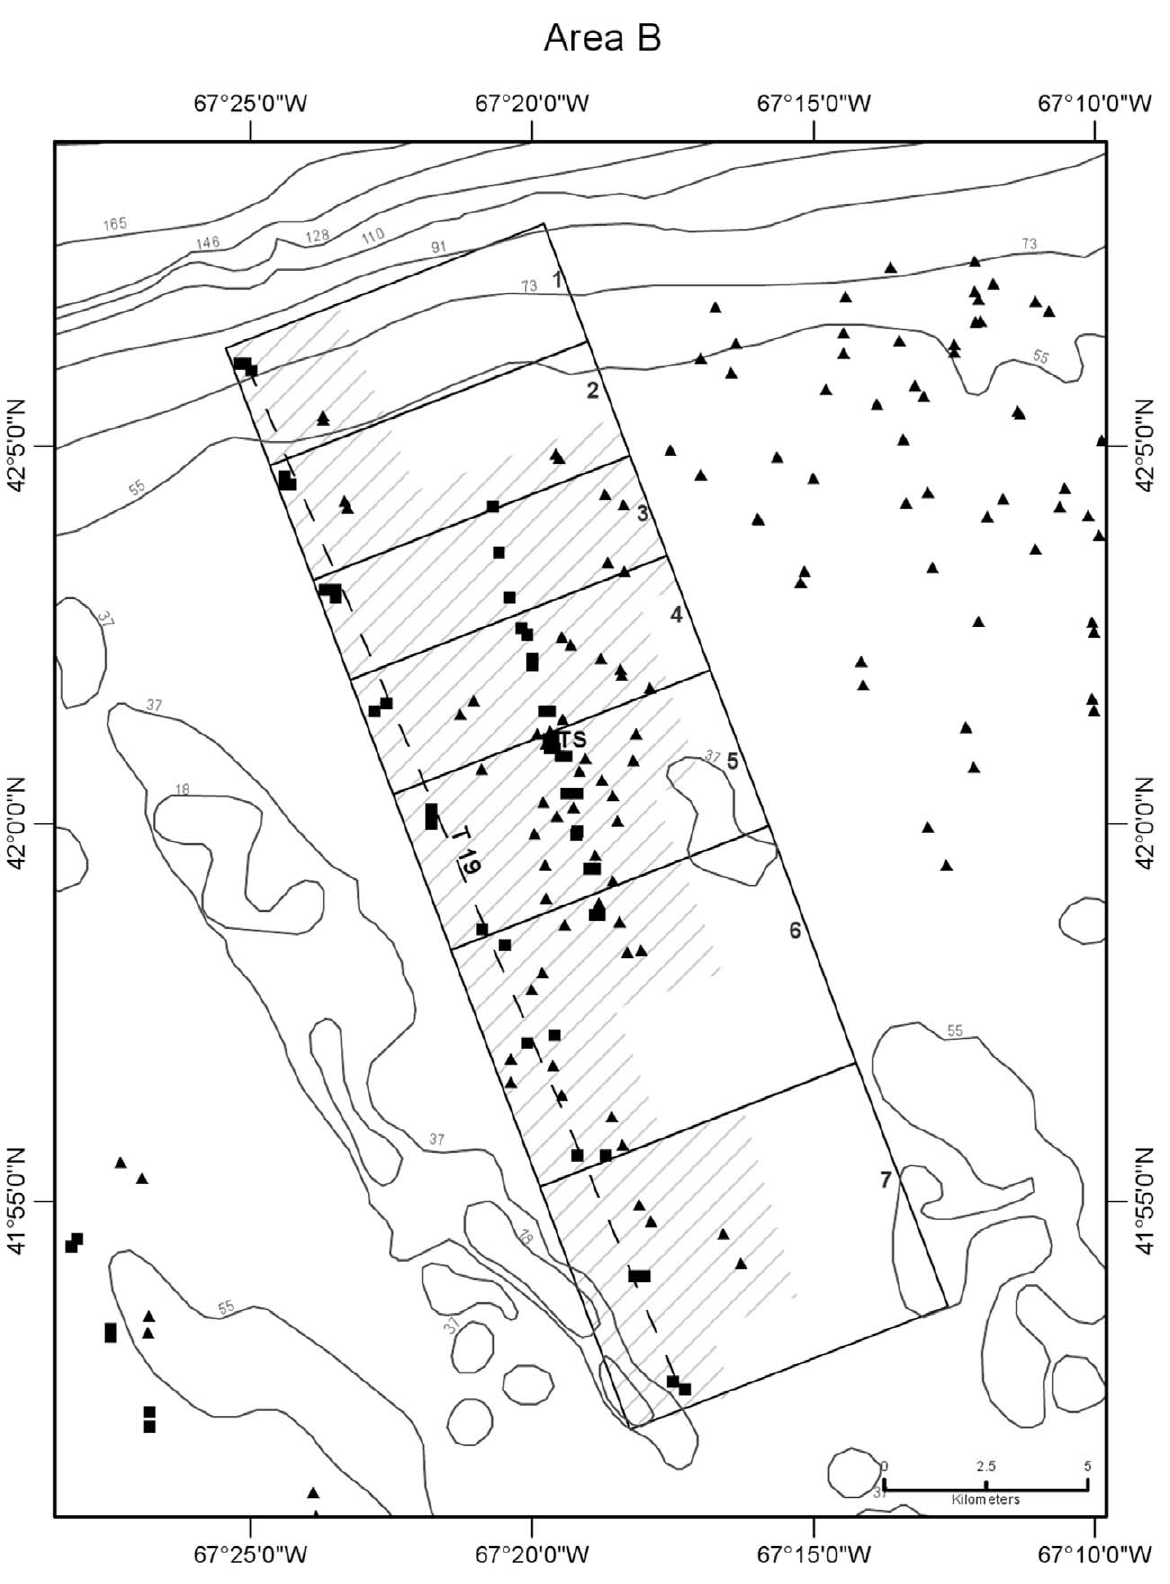
Figure 3. Detail map of study area B showing subareas and seabed temperature stations. Data were obtained from the northern margin of Georges Bank in August 2009. Subareas 1–7 are shown as boxes subdividing the larger area B box, labeled just inside their right (northeastern) margin. Dashed line is path of CTD transect 19 that was sampled around high and low tides (Fig. 7B, Table 1). TS is the site of time-series station (Fig. 8, Table 3). Other symbols and depth contours are as in Fig. 2. doi:10.1371/journal.pone.0055273.g003 PLOS ONE | www.plosone.org 5 February 2013 | Volume 8 | Issue 2 |